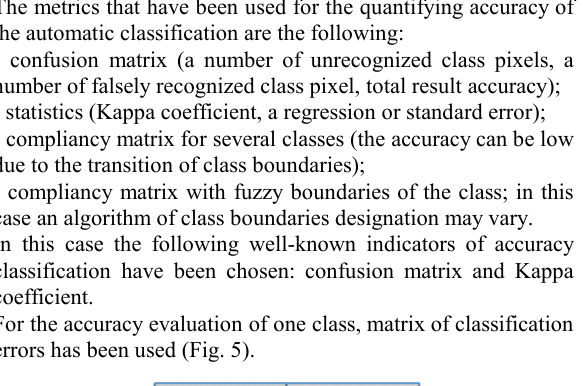
Figure 4. The main stages of thematic processing of satellite imagery